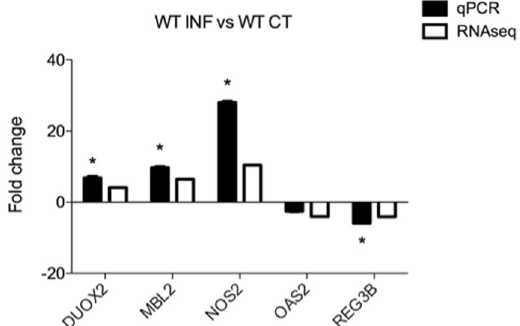
Figure 1. qRT-PCR analysis for genes identified by RNA-seq as differentially expressed between G . muris infected and uninfected C57BL/6 WT mice. Genes that are significantly differentially regulated between the 2 groups, as measured by qRT-PCR, are marked with an asterisk ( * p <